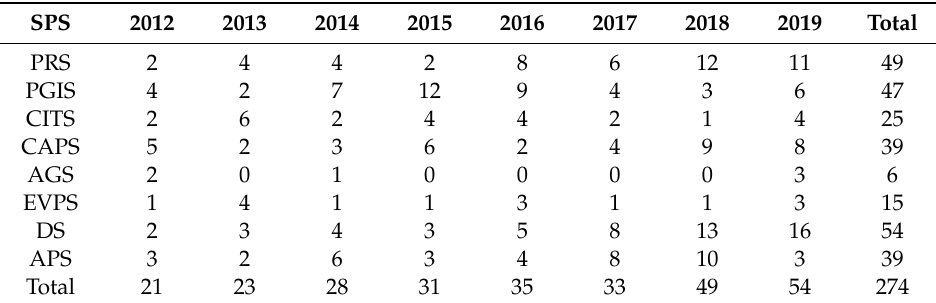
Table 8. Relationship between type of SPS and year of publication.